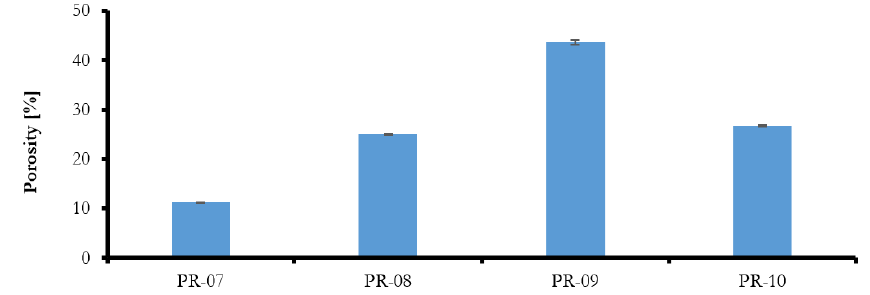
Figure 7. Effect of different solvent on blended membrane porosity.